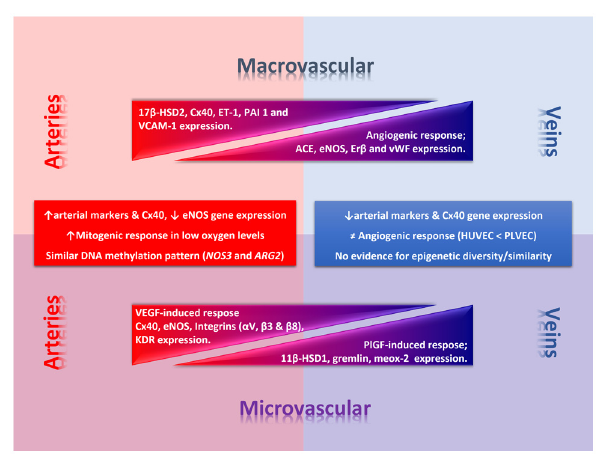
FIGURE 2 | Phenotypic diversity in the umbilico-placental endothelium. Umbilical (macrovascular) and placental (microvascular) endothelial cells present a phenotypic diversity characterized by a differential response to angiogenic factors and gene expression of key endothelial genes. In the figure thickness of the triangle denotes deferential relative expression (or response) regarding arteries or veins at each level. Square text box includes common traits between macro- and micro-vascular arterial or venous endothelial cells. 11 β -HSD1, 11 β -hydroxysteroid dehydrogenase 1; 17 β -HSD2, 17 β hydroxysteroid dehydrogenase 2; ARG2, arginase-2 gene; Cx40, conexin-40; eNOS, endothelial nitric oxide synthase; ET-1, endothelin-1; KDR, vascular endothelial growth factor (VEGF) receptor 2; NOS3, eNOS gene; PAI